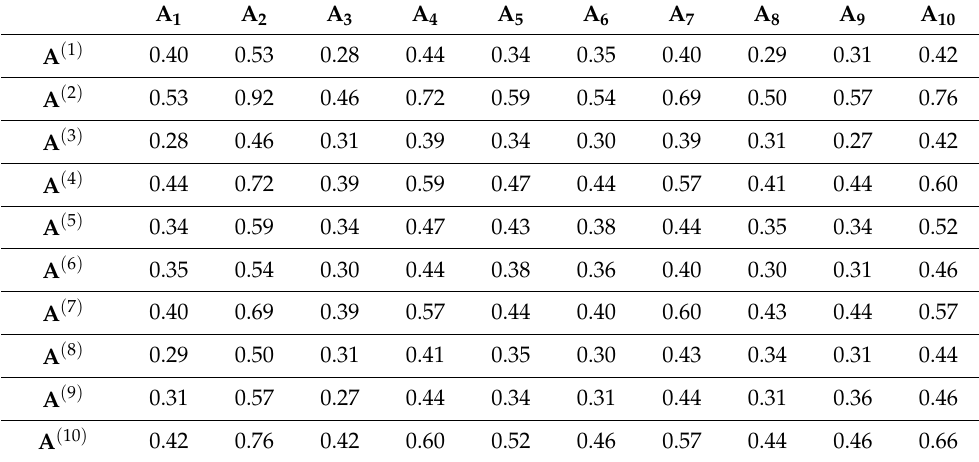
Table 2. The consistency matrix of the fuzzy decisions.